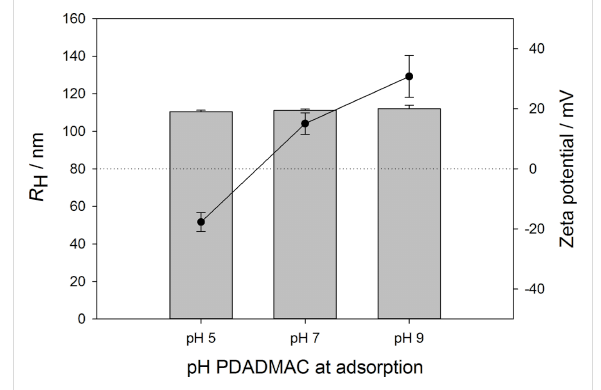
Figure 3: Particle radii (bars) and zeta potential (line plot) of PLGA- PEI-PAA-PDADMAC nanoparticles in dependence of the pH value during PDADMAC adsorption. All experiments were performed in tripli- cate, average values ± standard deviations are